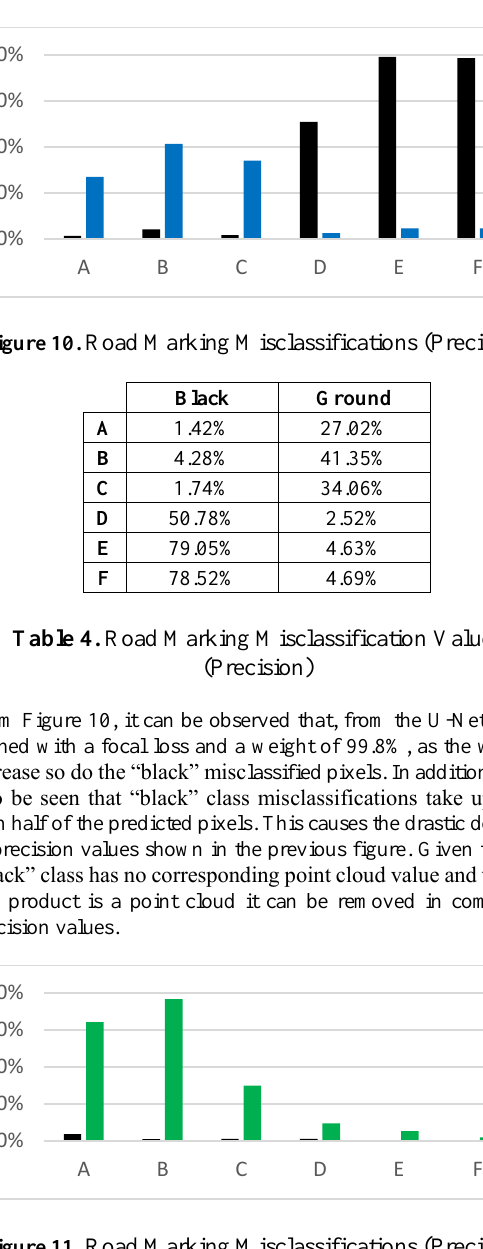
Figure 11. Road Marking Misclassifications